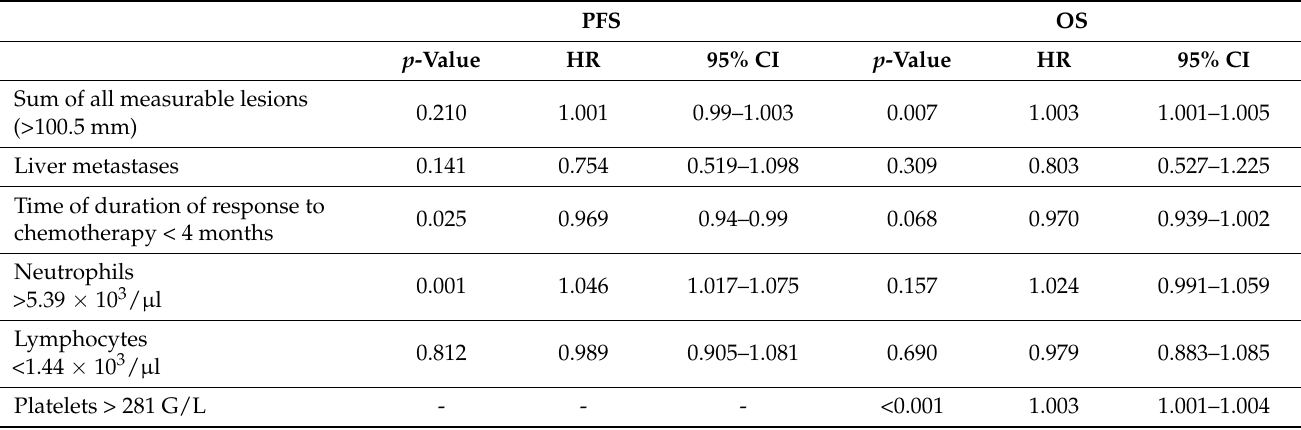
Table 6. Statistics for the variables in the tested model: multivariate